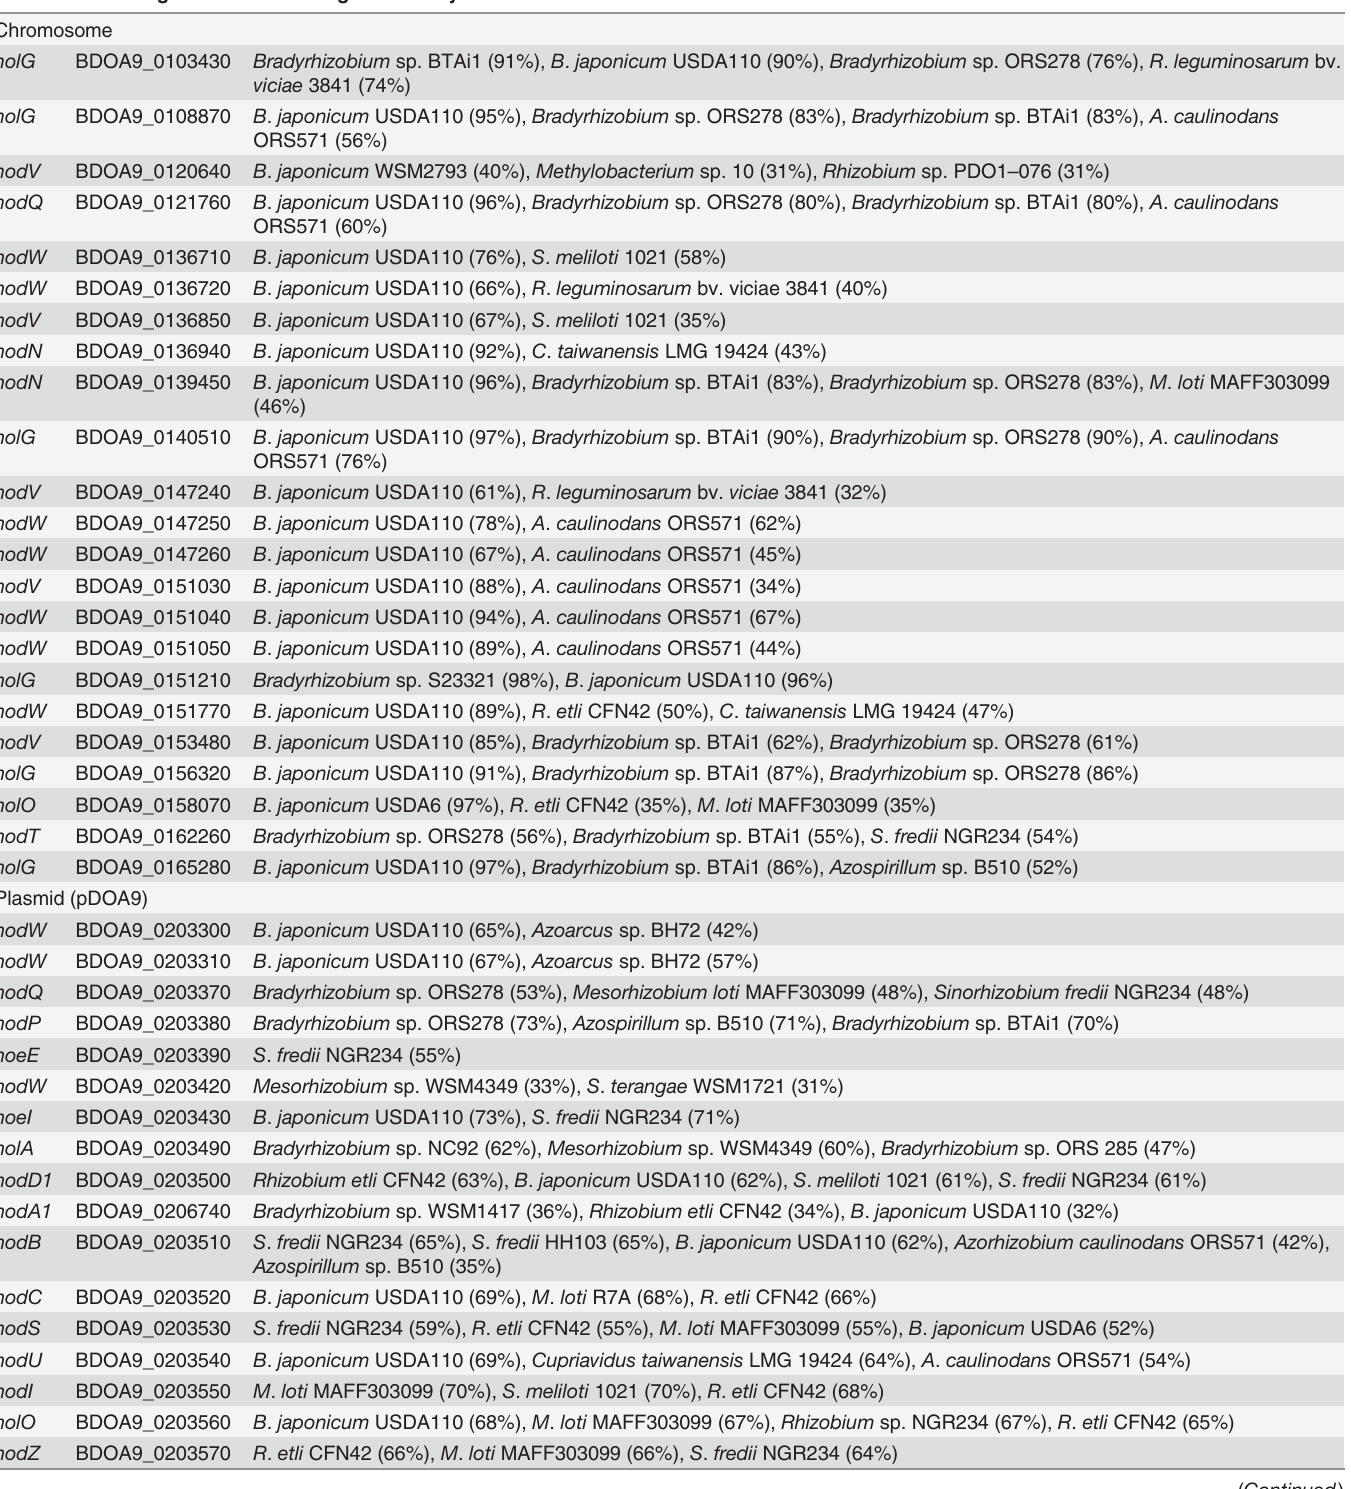
Table 2. Nodulation genes detected in the genome of Bradyrhizobium sp. DOA9 and higher BLASTP similarity with other microorganisms. Gene Locus tag Percentage of identity in BLASTP